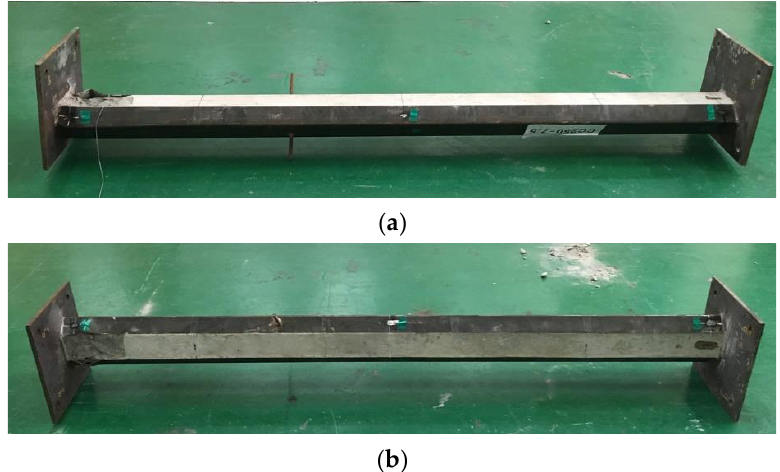
8 of 19 Figure 10. Dimensionless axial load vs. vertical stain for PAL25: ( a ) top (T1 – 4); ( b ) middle (M1 – 4); ( c ) bottom (B1 – 4). In the case of PAL25, the strains in the bottom and middle sections were similar and did not reach yield strain, as shown in Figure 10b,c. On the other hand, the top strains were much larger than the strains in the bottom and middle sections, and some strains reached yield strain. This implies that the load was concentrated at the top of the test specimen and the bottom and middle sections remained in an elastic state. This is because the load was applied from the top of the specimen, and the length of PAL25 is larger than PAL15. Consequently, the axial load along the length is not uniform and local failure of the upper part occurred first. Additionally, with increasing the length of the specimen, the strain distribution in the specimen became nonuniform, and additional reinforcements